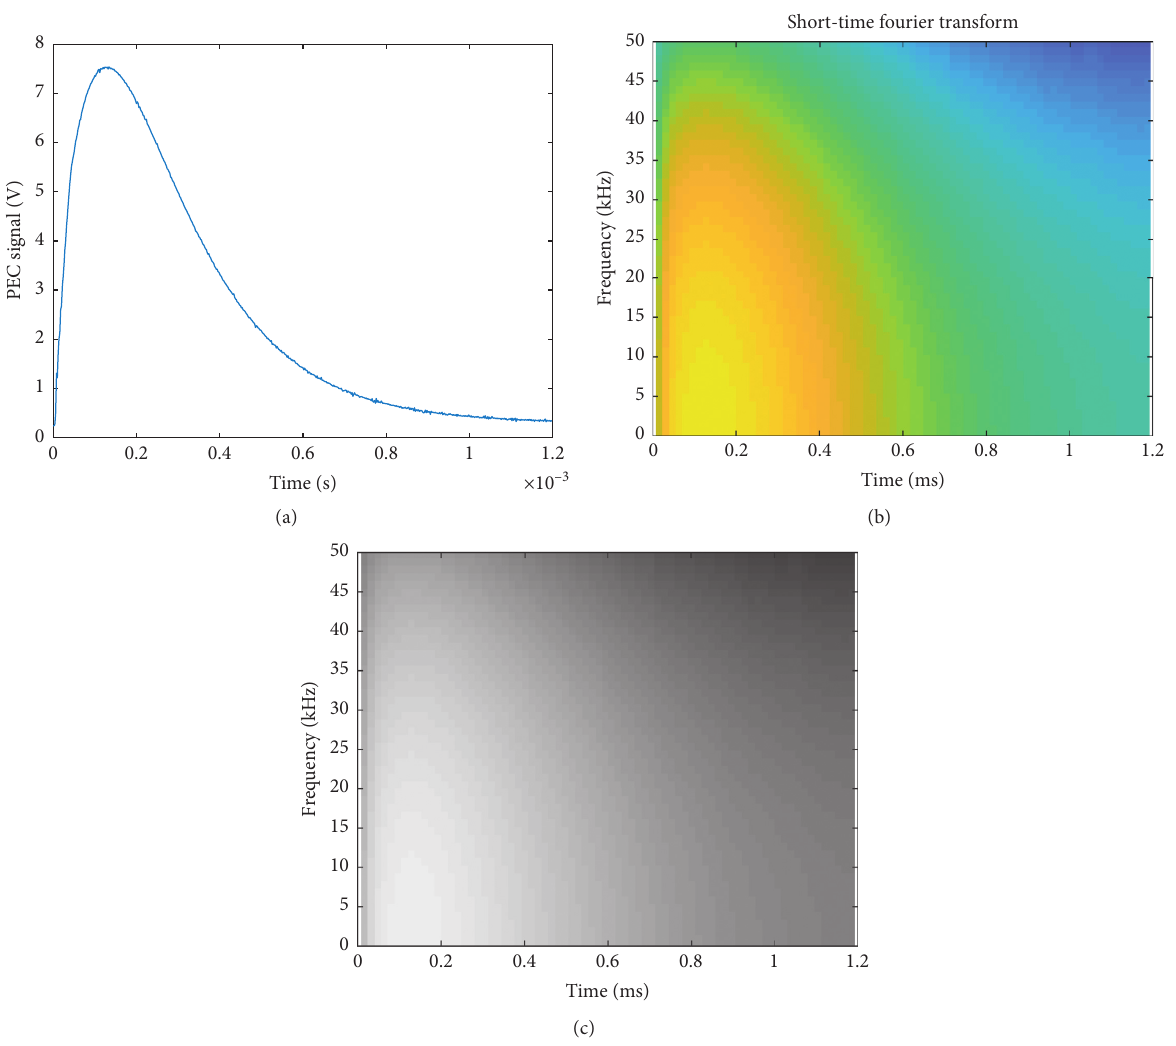
Figure 5: TFR obtained using the STFT method: (a) PEC signal; (b) TFR; (c) gray